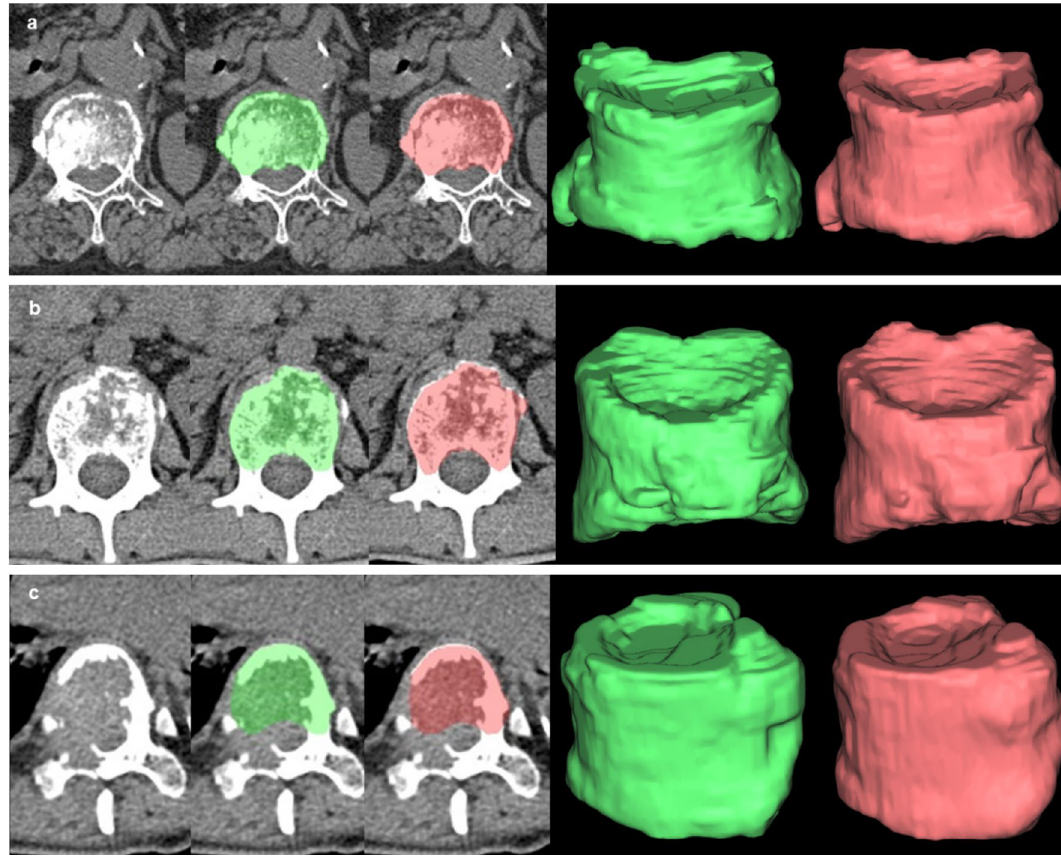
Figure 3. Representative images of automated segmentation of fractured vertebral bodies from the internal test set. ( a ) a 76-year-old woman with an acute benign fracture (voxel size, 0.287 × 0.287 × 1 mm), ( b ) a 19-year- old man with a malignant fracture from metastatic Ewing sarcoma/PNET (voxel size, 0.293 × 0.293 × 1 mm), and ( c ) a 68-year-old man with a malignant fracture from metastatic renal cell carcinoma (voxel size, 0.309 × 309 × 1 mm). When the osseous margin of the vertebral body could not be fully traced because of bone destruction, an imaginary line was drawn based on the contralateral normal appearing cortex or the most adjacent intact vertebral body as shown in ( c ). The green shaded area denotes segmentation by the human experts and the red shaded area denotes automated segmentation. The last two columns show three-dimensional volume meshes by the human experts (green) and the automated algorithm (red).